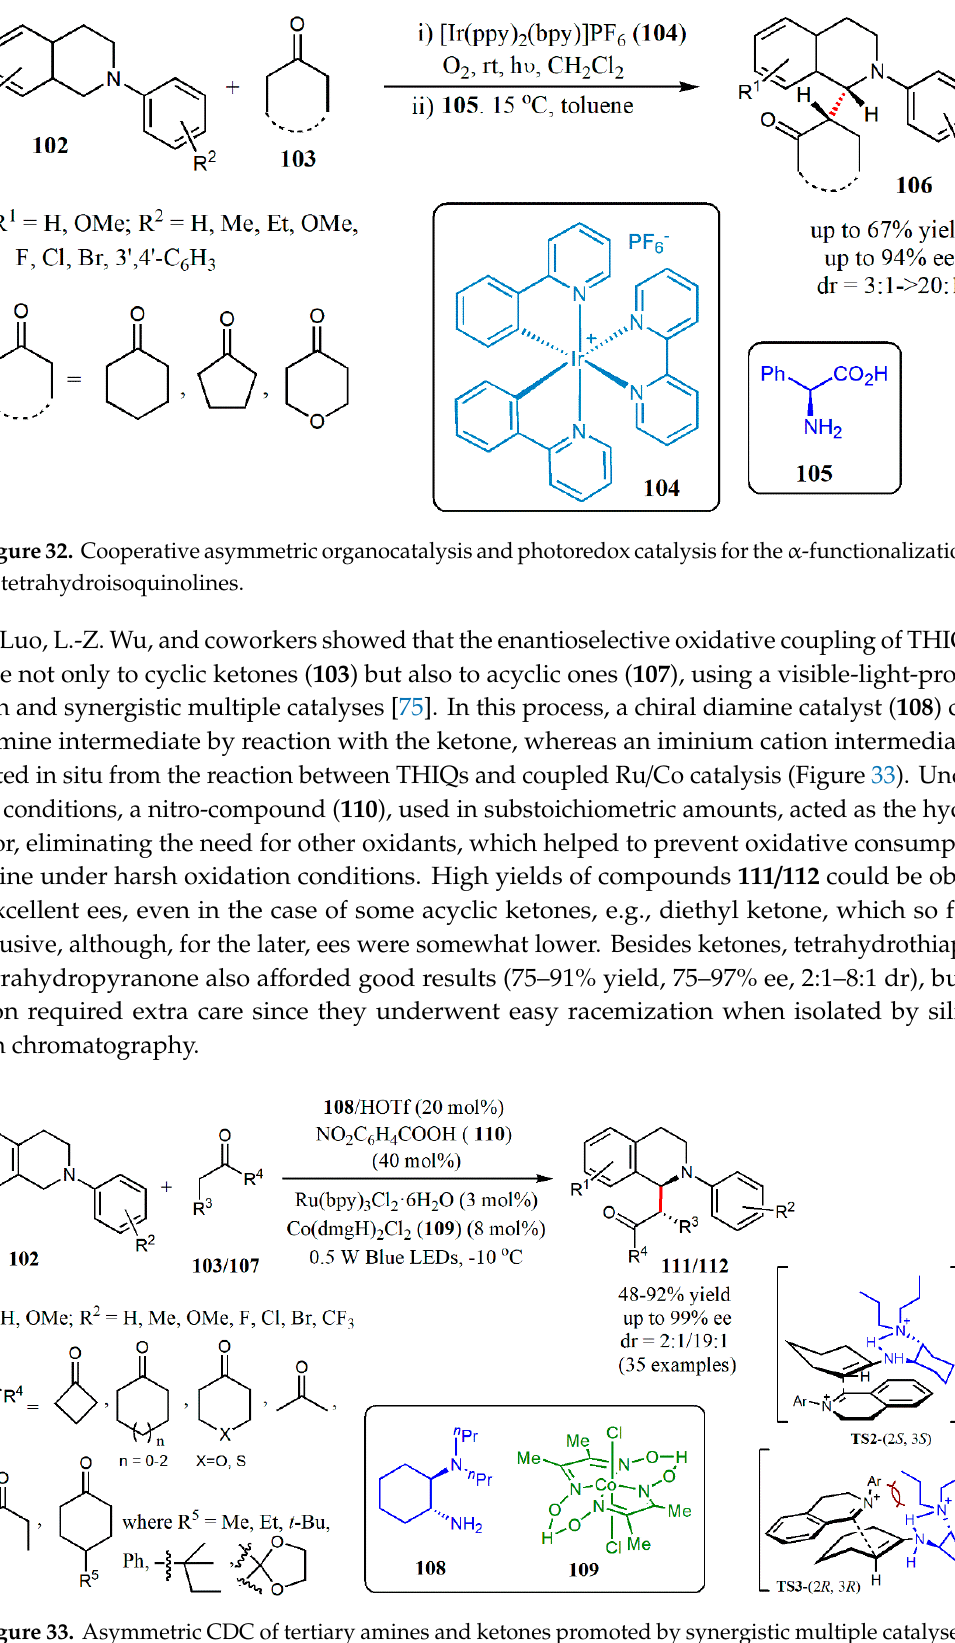
Figure 33. Asymmetric CDC of tertiary amines and ketones promoted by synergistic multiple